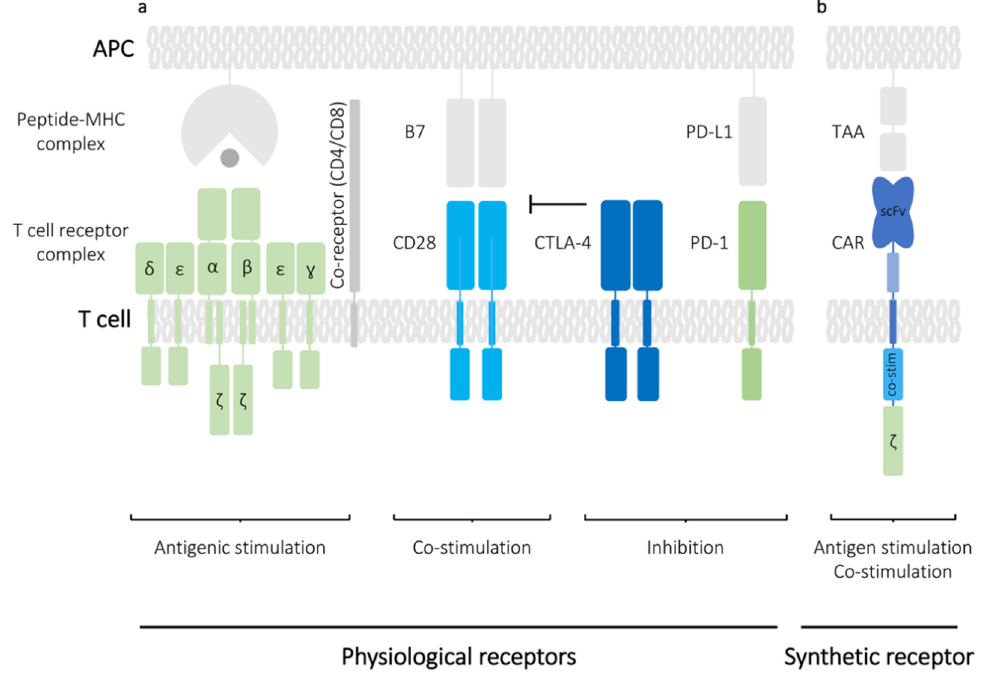
Figure 1. Overview of the different types of receptors present on the surface of T cells and their interaction partners. ( a ) The T cell receptor (TCR) complex is composed of eight polypeptide chains: αβγδ 2 ε 2 ζ . The hypervariable loops located at the top of the αβ dimer are responsible for recognition of antigenic peptides presented by major histocompatibility complex (MHC) I or II on the surface of an antigen-presenting cell (APC). Upon interactions of peptide-MHC with the TCR, a co-receptor binds to the side of the MHC. Co-receptors CD8 and CD4 interact exclusively with either MHCI or MHCII, respectively, and mature T cells express only one of the two co-receptor types. Interactions of co-stimulatory receptor CD28 with B7 are required for full activation of the T cell and can be inhibited by CTLA-4 which competes with CD28 for B7 binding. Another inhibitory receptor on the T cell surface is PD-1 which is triggered upon by binding to PD-L1 on the apposed cell. ( b ) Chimeric antigen receptors (CAR) permit the T cell response to be redirected towards a selected surface antigen, for example a tumour-associated antigens (TAA). The extracellular domain of CARs relies on a single chain variable fragment (scFv) for antigen recognition. Most commonly, the signalling chains of CARs consist of intracellular domains derived from co-stimulatory receptors (co-stim) and the ζ chain of the